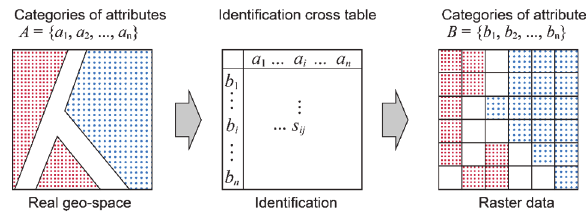
Figure 1 . Identification error occurrence in the raster data creation